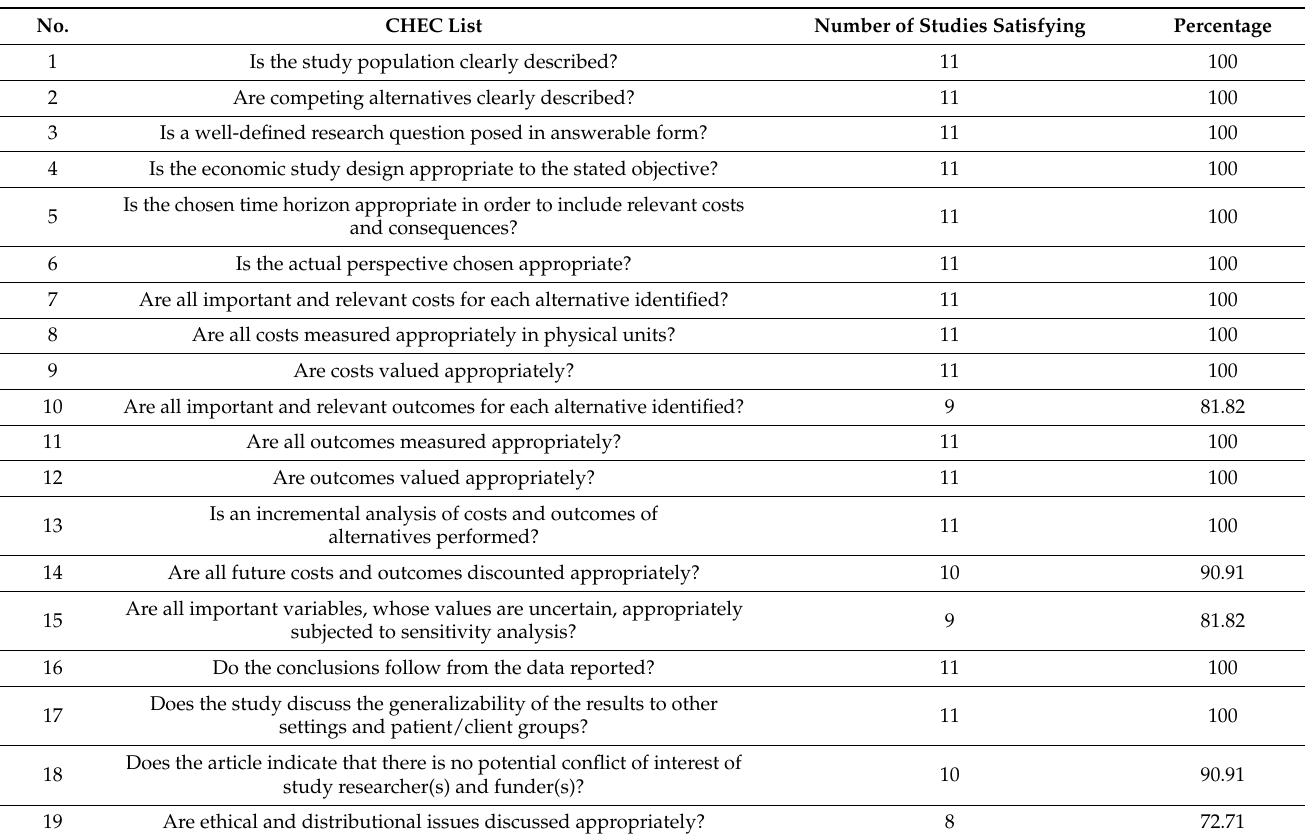
Table 5. Quality assessment using the CHEC check